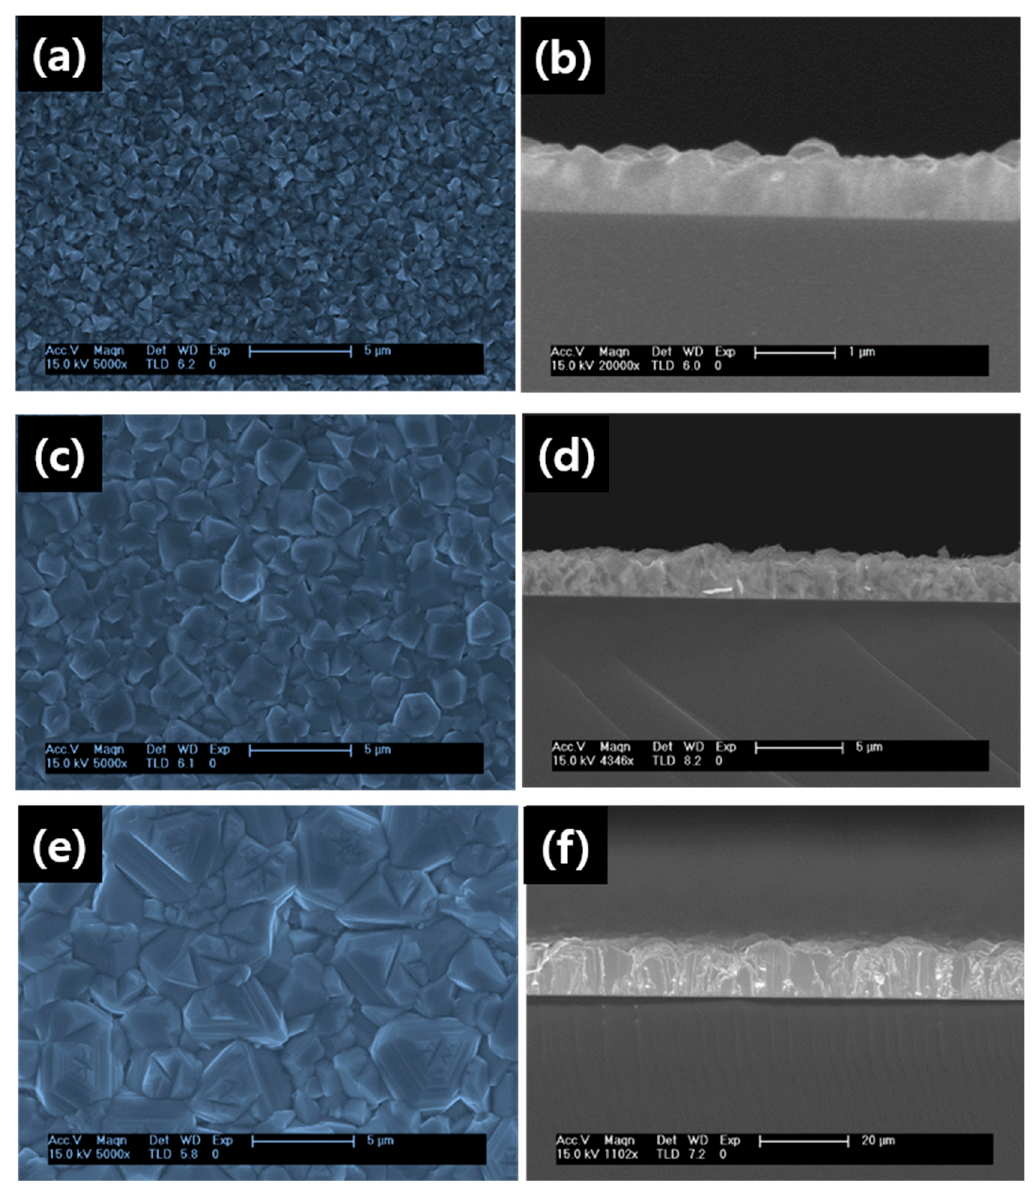
Figure 2. Scanning electron microscopy (SEM) images of CdTe grown at different substrate temperature ( a ) 250 ° C ( c ) 350 ° C ( e ) 450 ° C along with their corresponding cross-sectional image ( b , d , f ).